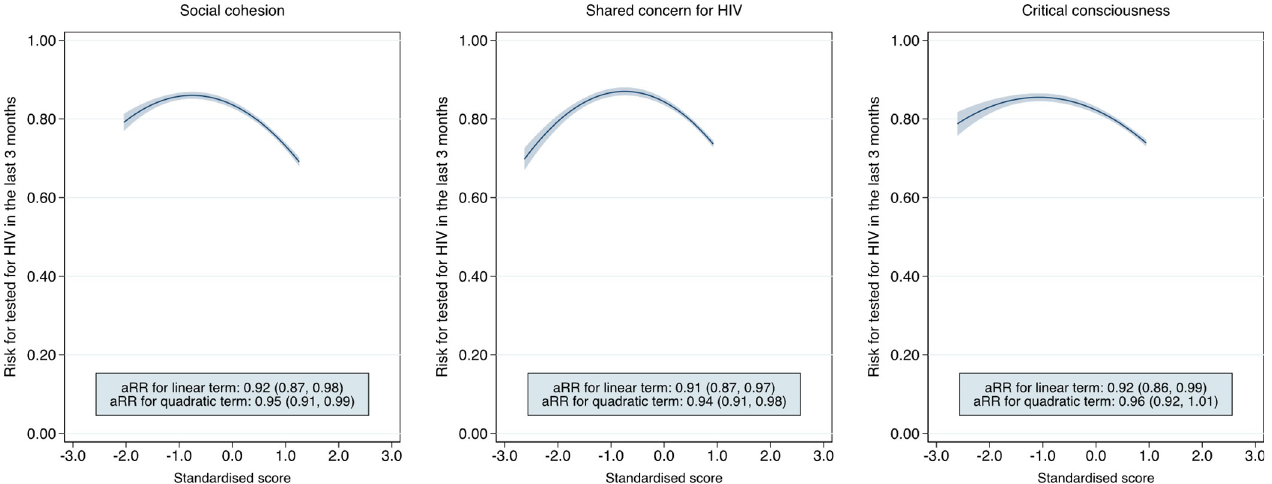
Fig 2. Prediction plots of recent HIV testing and potential mediators. aRR, adjusted risk ratio. Prediction plots with fitted values and 95% CIs. Prediction values obtained from Poisson regression of recent HIV testing on the linear and quadratic terms for the potential mediators, as standardised scores, in the community-led HIV self-testing arm. Fitted values obtained from a quadratic model of prediction